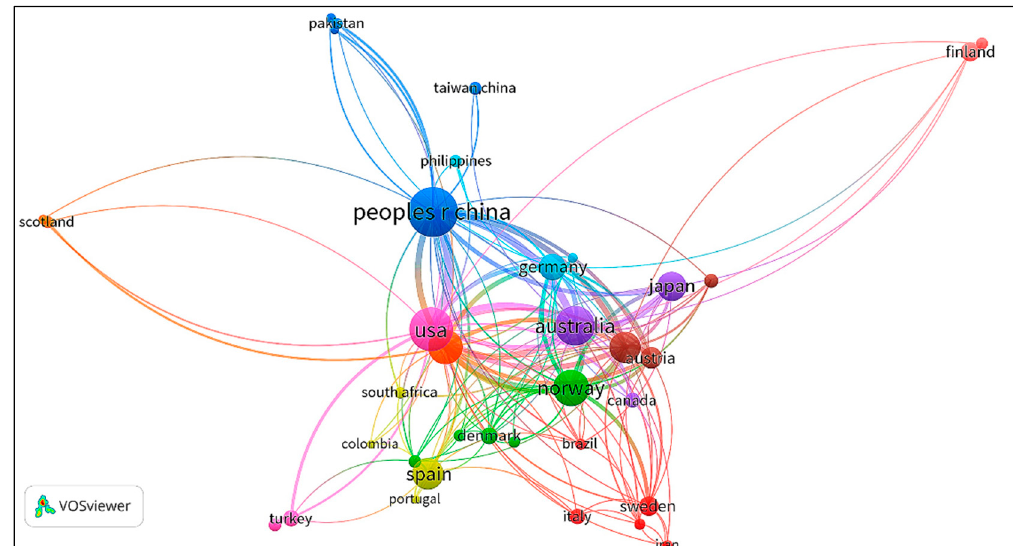
Figure 4. Network map of country (region) collaboration. Table 3. Top 10 institutions based on frequency.